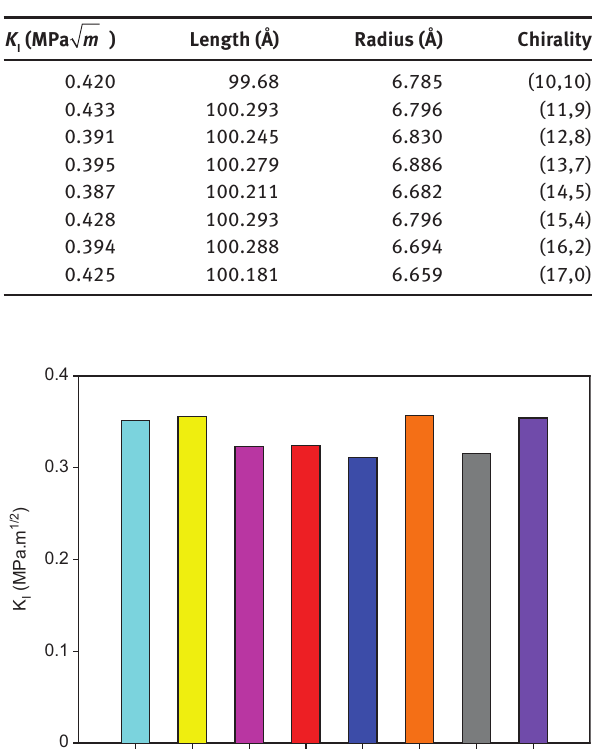
similar radius and